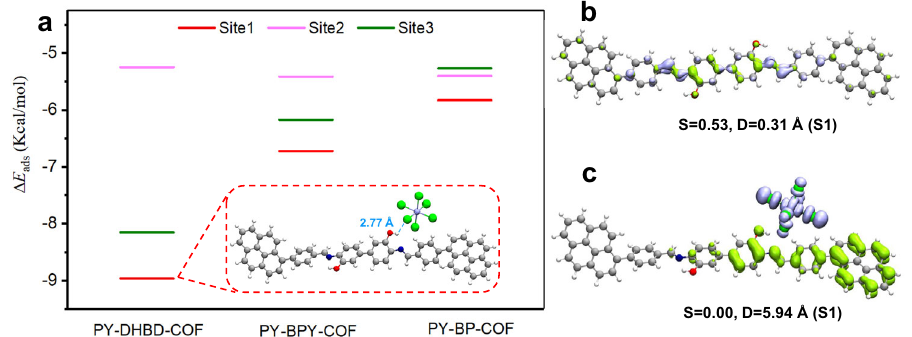
Fig. 6 Theorectical understanding of the photodeposition. a The adsorption energy of PtCl 6 2 − on three sites of PY-DHBD-COF, PY-BPY-COF, and PY-BP- COF (Insert: the most stable adsorption con fi guration of PY-DHBD-COF-PtCl 6 2 − ). The hole (lime) and electron (violet) distribution of S1 excited state on PY-DHBD-COF ( b ) and the complex PY-DHBD-COF-PtCl 6 2 − ( c ). S is the overlap integral of hole-electron distribution and D means the distance between centroid of hole and electron. The balls in different colors represent different atoms: H, white; C, dark gray; N, blue; O,